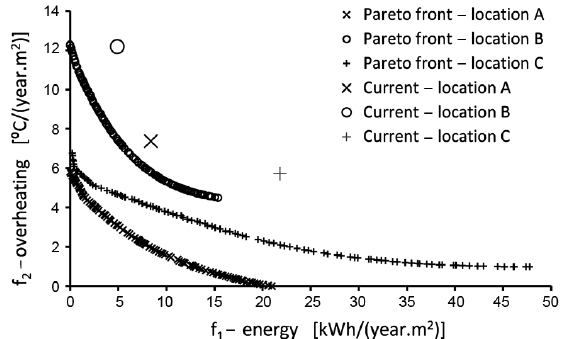
Fig. 4. Multi-objective optimization output